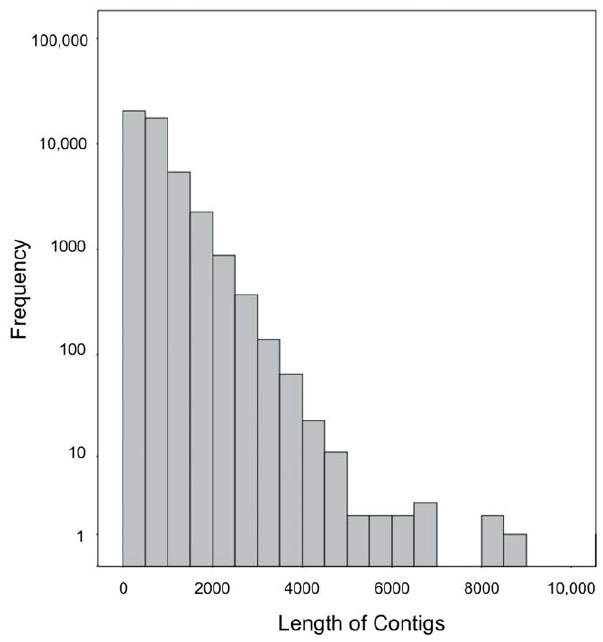
Figure 1. Histogram of contig sequence length. Contig sequences were generated from de novo assembly of both libraries (n=42,953) and average length is 728 bp. Note logarithmic scale for frequency axis.